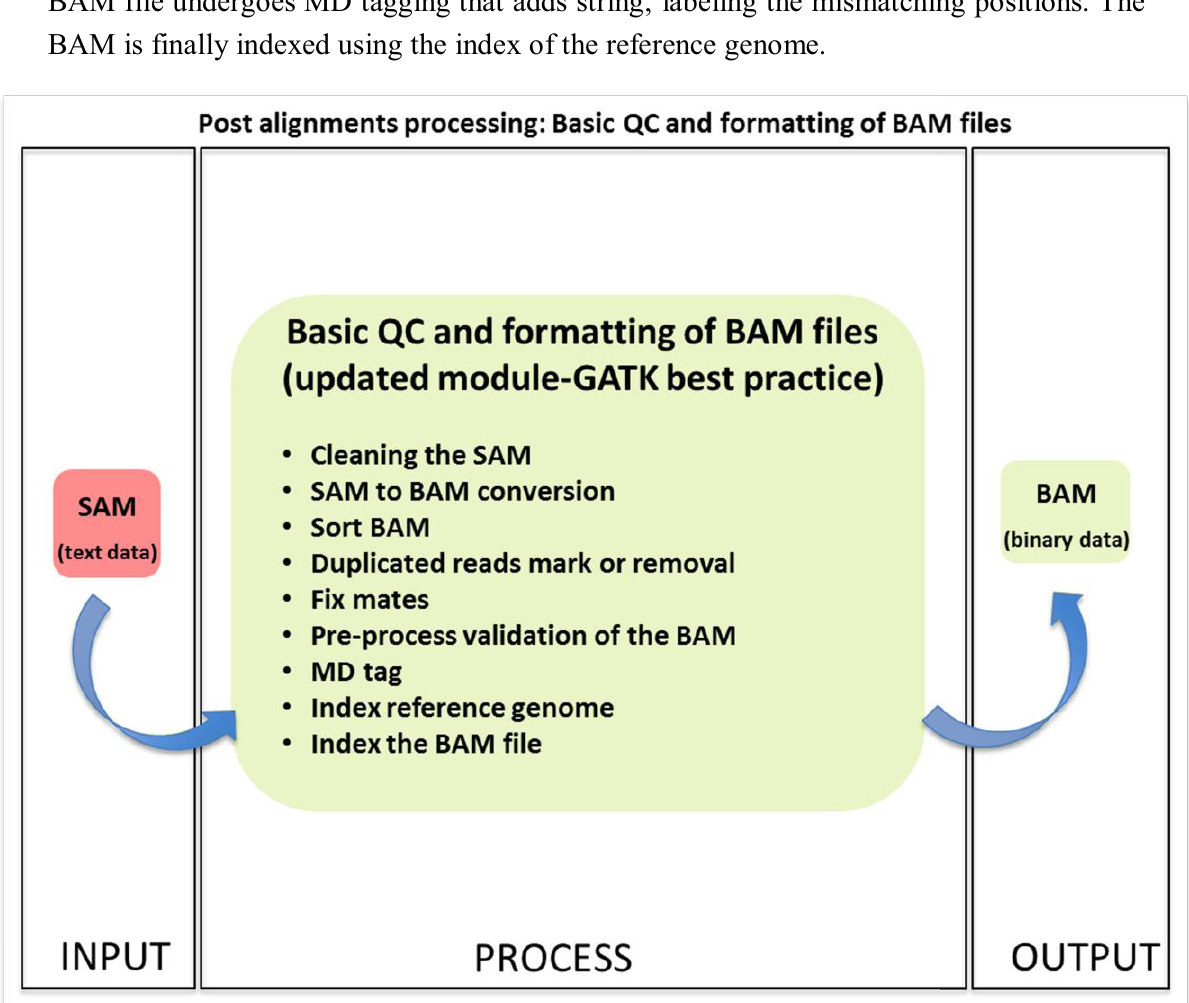
Figure 5. A snapshot of the general organization of the Basic QC workflow (2.1.3).